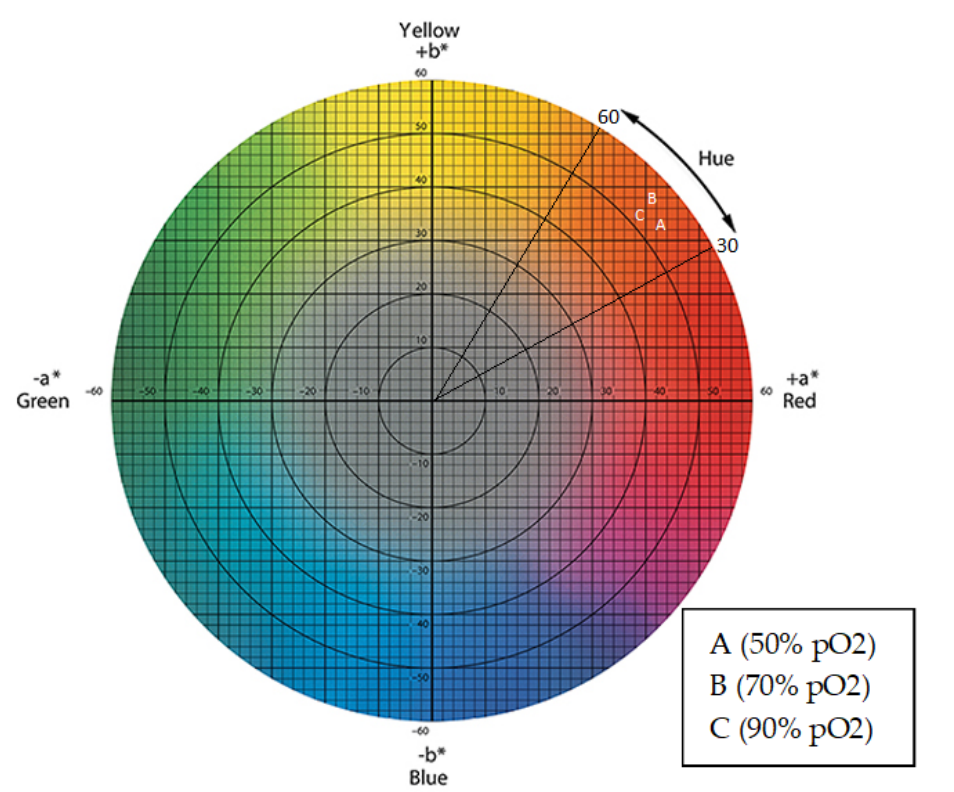
Figure 11. Colorimetric parameters in the color wheel describing the coordinate axis L*, a*, b*. The color hues are depicted as ( A – C ) for pO 2 at 50%, 70% and 90%, respectively. An alternative way of specifying the color coordinates is using C*, h* values in place Table 4. Colorimetric (D65) values L*a*b*c*h of extracellular extracts from 2 L bioreactor fermenta ‐ tion with pO 2 at 50%. of a*, b*. Our data reported in Tables 1–3 indicated that all h* values were similar for the three different runs and in the range of 45 ± 2. As h* values are expressed in degrees, with 0 ◦ being a location on the +a* axis, 90 ◦ would be a point on the +b* axis, and from the obtained value (45 ± 2), it is clear that the pigment produced is described as red, indicating the color tone. The chroma coordinate (C*) explains the distance from the lightness axis and is around the value of 80 for all three runs towards the brighter shade, with 0 being at the center, denoting the grey shade. The concept of hue and chroma values agrees well with visual experience and for visual comparison, Figure 10c is appended here to have a correlation between color hues and values obtained using the CIEL*a*b*